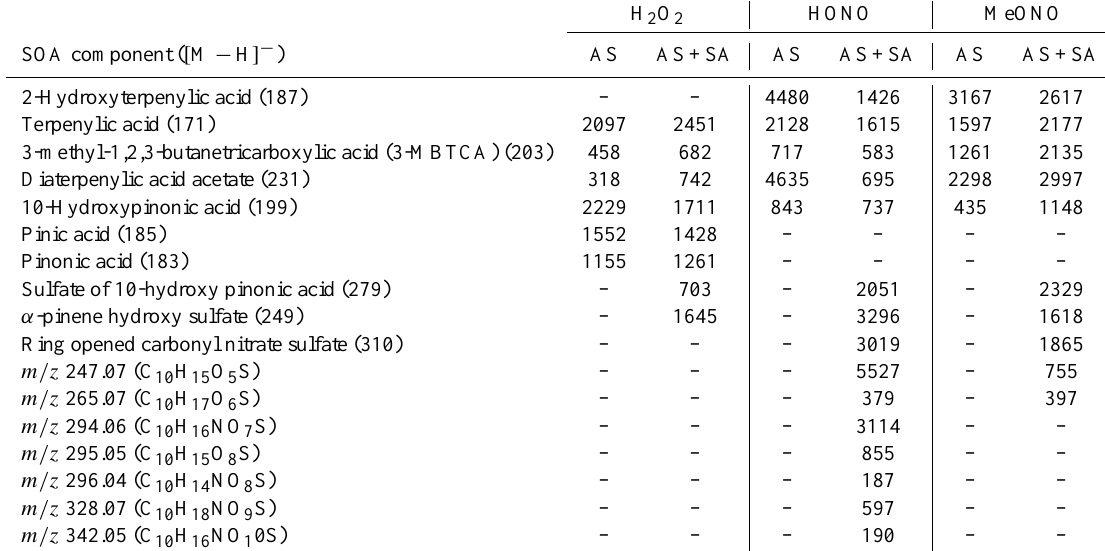
Table 3. Peak areas scaled to low-NO x AS seed SOA loading from UPLC chromatograms of carboxylic acids, organosulfates, and nitrooxy organosulfates from the photooxidation of α